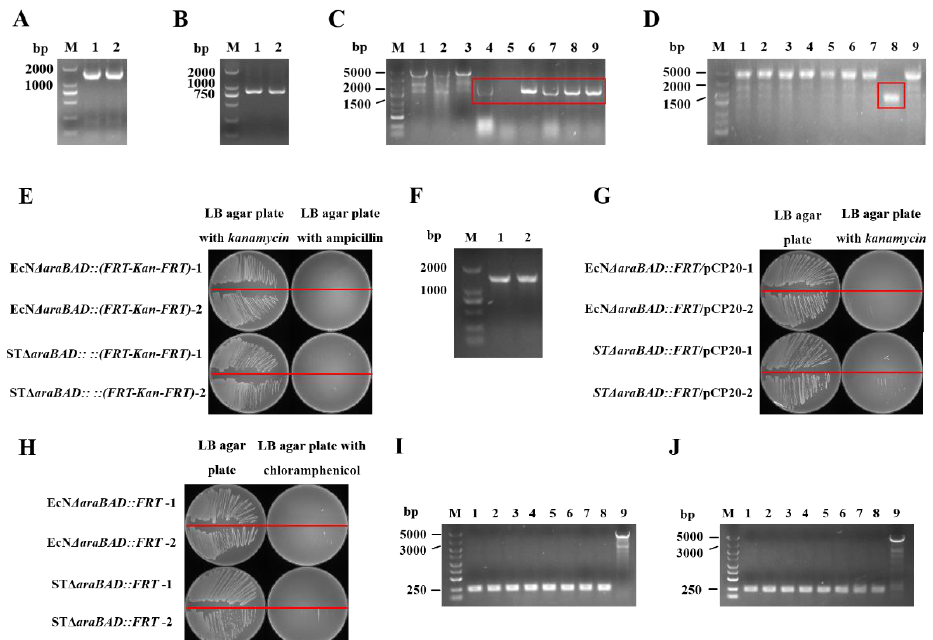
Figure 7. Construction of engineering strain EcN with araBAD deletion mutation and ST with araBAD deletion mutation. ( A ) The amplification of linear FRT-kanamycin-FRT fragment, band 1: linear FRT-kanamycin-FRT fragment containing 56-nt homology arms targeting the araBAD gene of EcN, band 2: linear FRT-kanamycin-FRT fragment containing 56-nt homology arms targeting the araBAD gene of ST; ( B ) The electrotransformation of pKD46, band 1: EcN clone, band 2: ST clone; ( C , D ) Colony PCR to identify the deletion of araBAD gene and the insertion of kanamycin gene of EcN or ST, and positive bands are marked in a red box; ( E ): The loss of pKD46 plasmid; ( F ): The electrotransformation of pCP20, band 1: EcN ΔaraBAD::kanamycin strain, band 2: ST ΔaraBAD::kanamycin strain; ( G ): Excision of kanamycin gene; ( H ): The loss of pCP20 plasmid; ( I , J ): Colony PCR to identify the deletion of araBAD gene engineered strain of EcN or ST, bands 1-8: engineered strain of EcN or ST, band 9: EcN wild type or ST wild type.